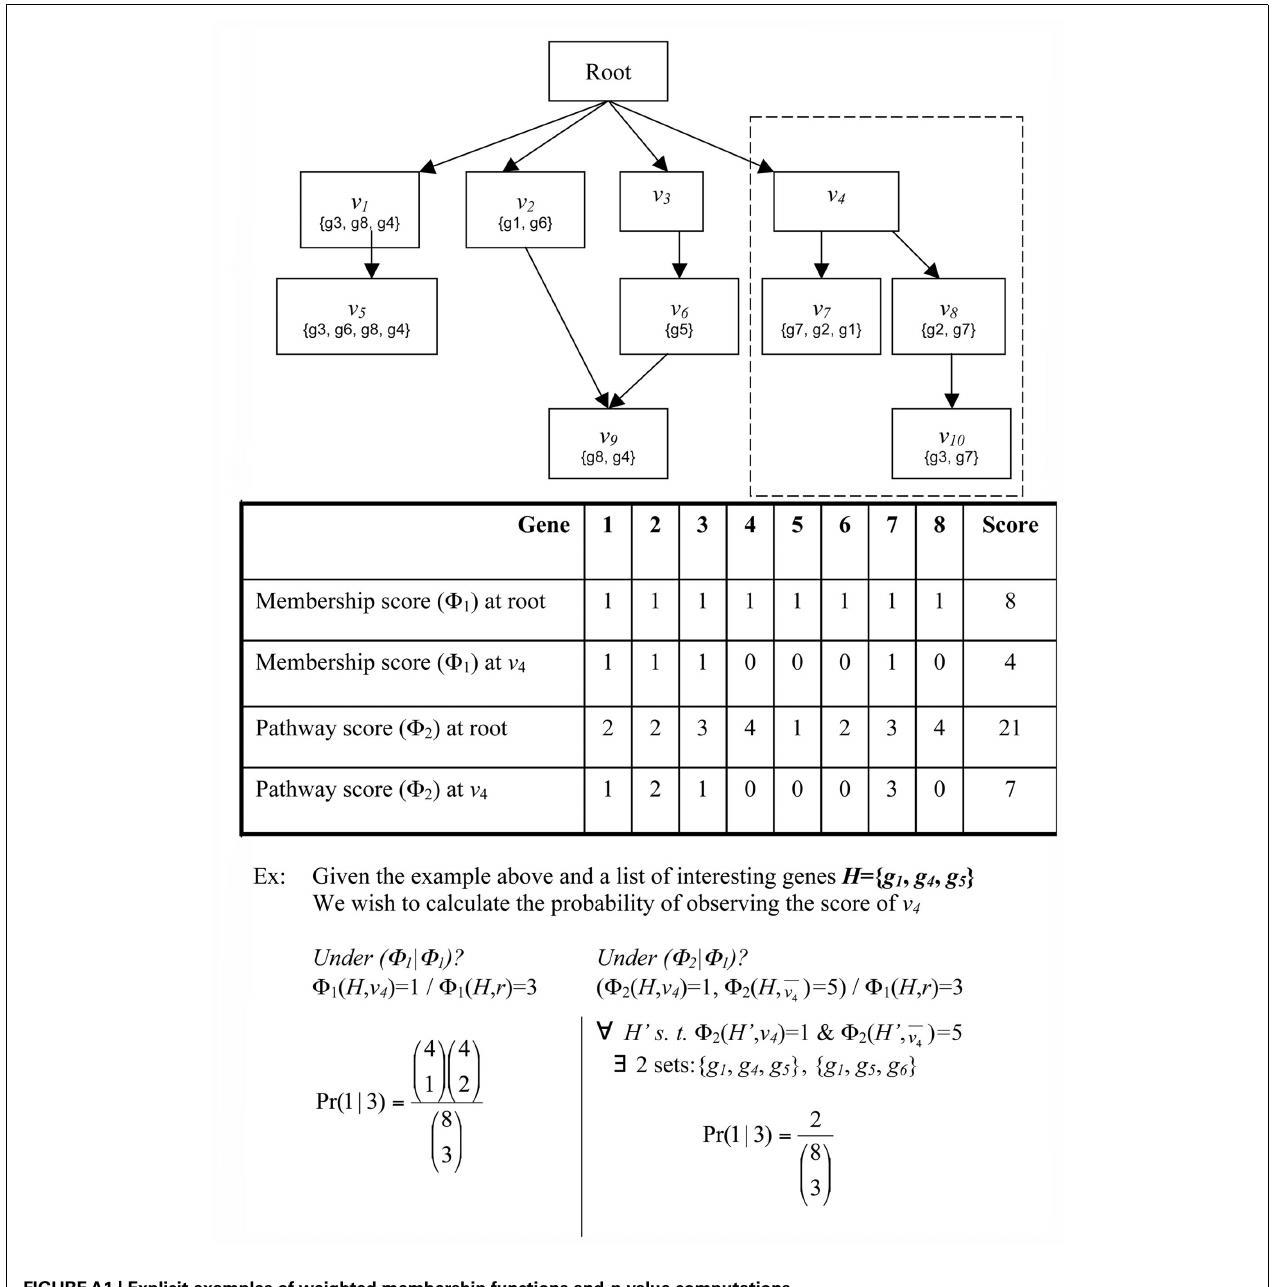
FIGUREA1 | Explicit examples of weighted membership functions and p -value